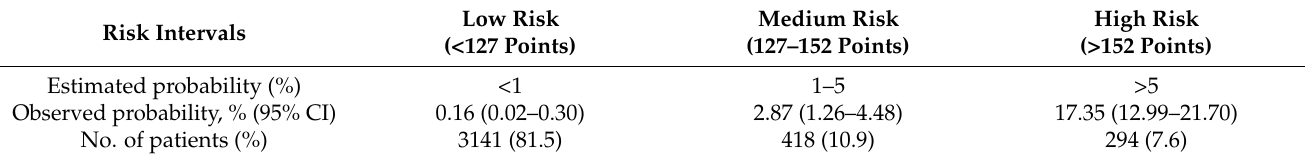
Table 3. Risk intervals of POT based on the nomogram.